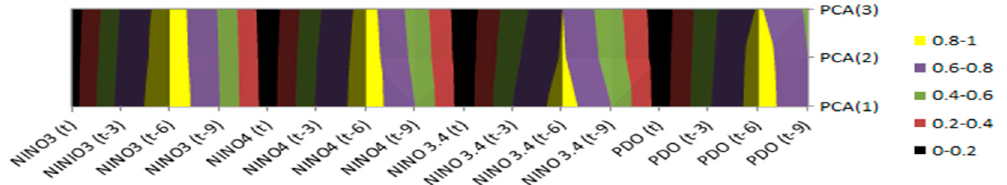
Figure 6. The upload of coe ffi cient values for the di ff erent climate indexes and di ff erent